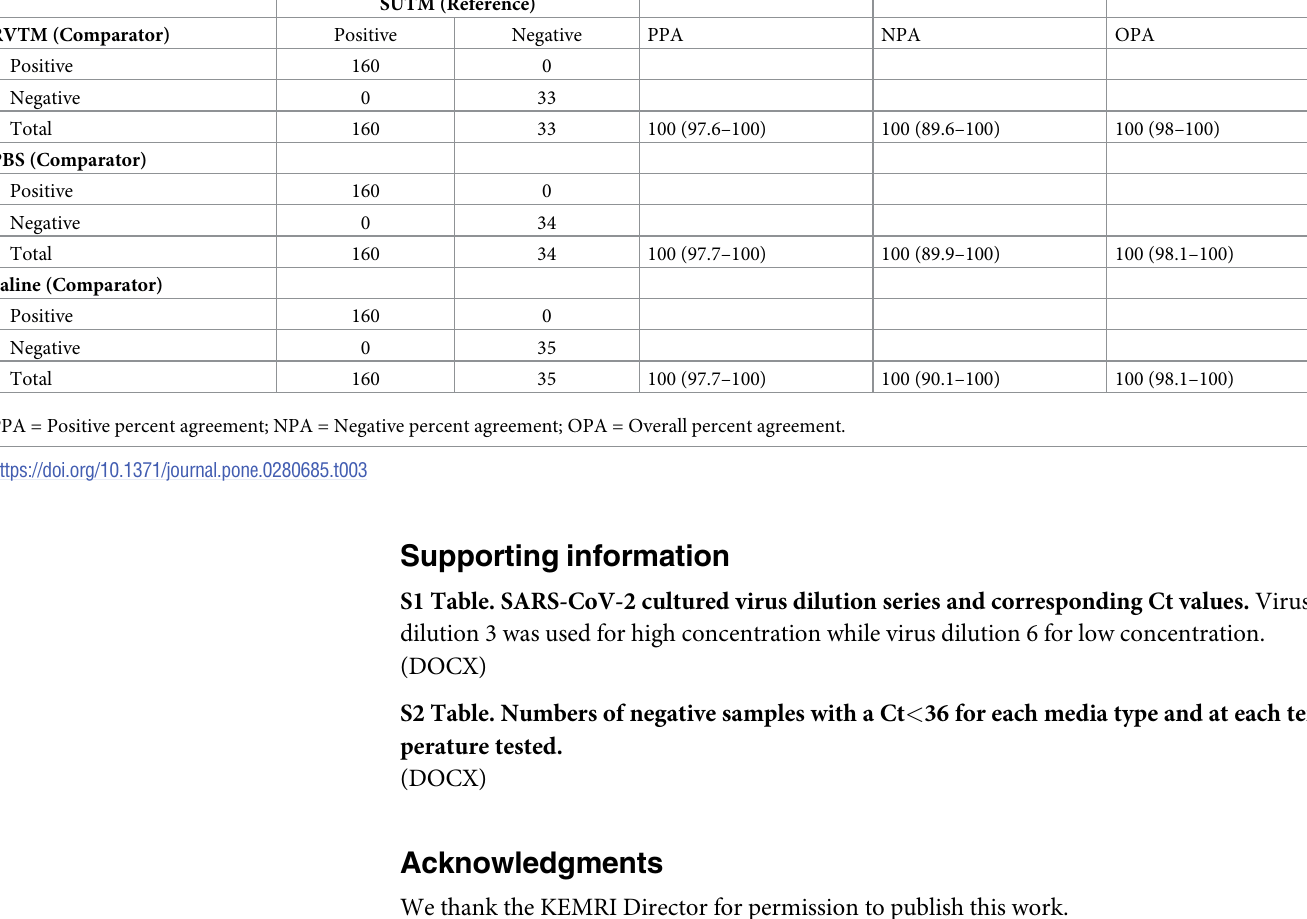
Table 3. Overall agreement between RVTM and SUTM for all time points and conditions �